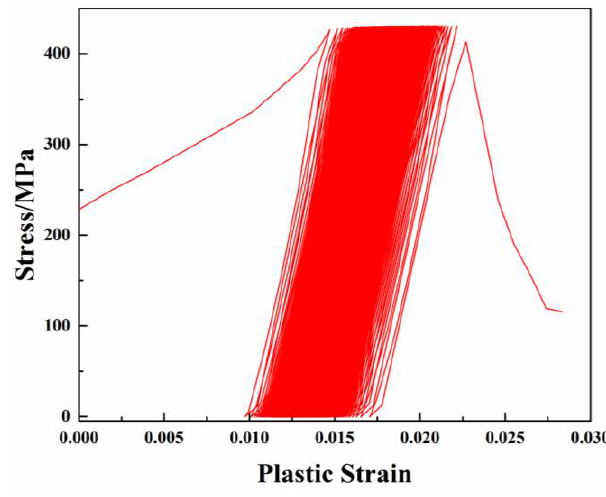
Figure 4. Cyclic stress-strain curve.